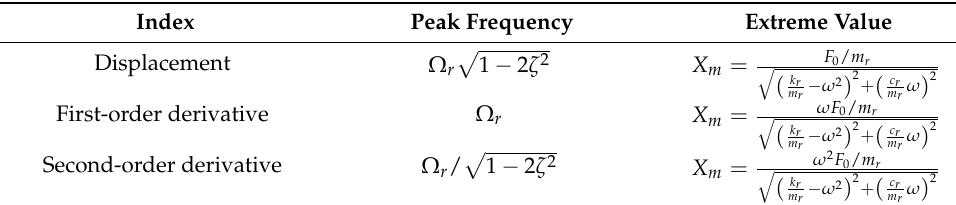
Table 1. Differential influence on